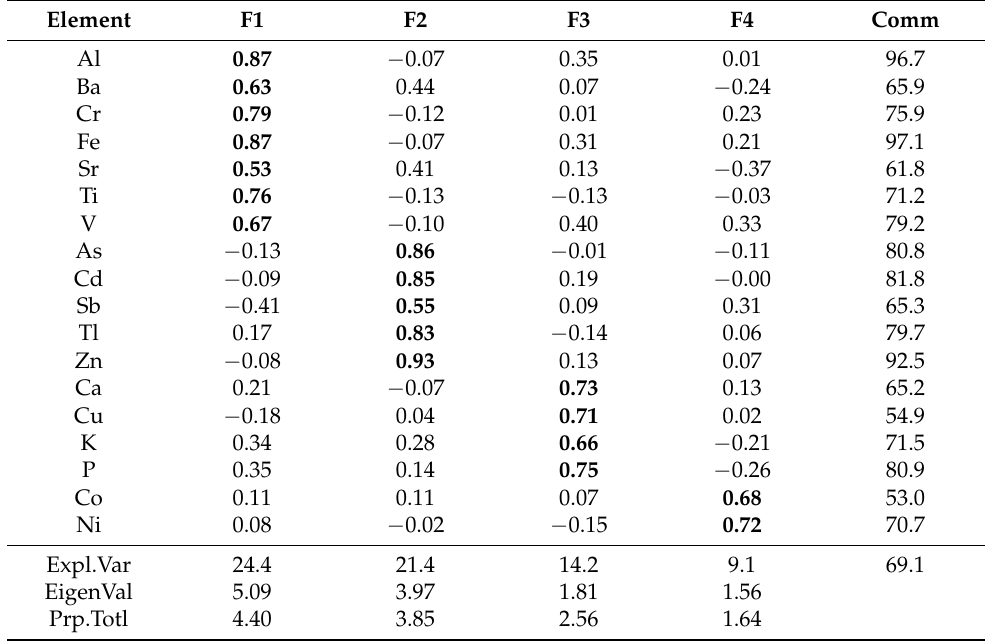
Table 4. Matrix rotating load of the dominant factors (factor